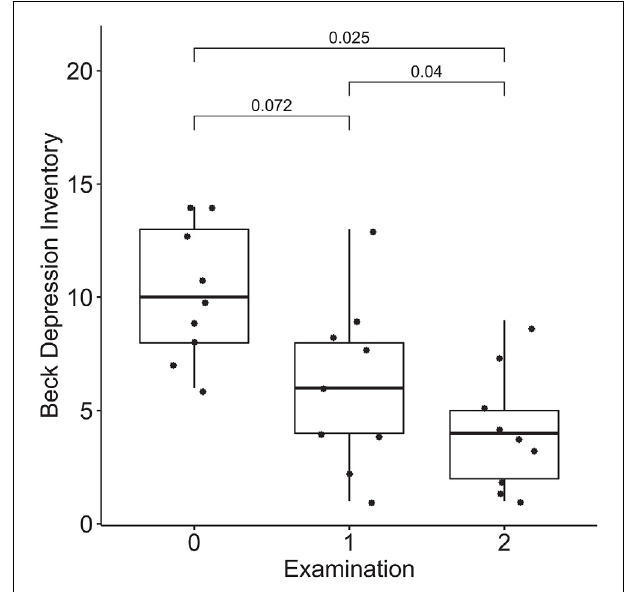
FIGURE 8 | Dynamics of depression after the course of infra-low frequency neurofeedback. The examination was performed three times: (0) 2 to 4 months before enrollment, (1) at enrollment; and (2) after the neurofeedback course. Significance for the Wilcoxon pairwise comparisons is presented on the plot ( p -value, Bonferroni corrected).